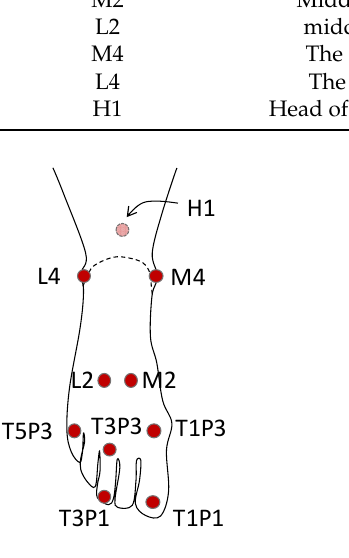
Figure 2. Position where the transmissibility was